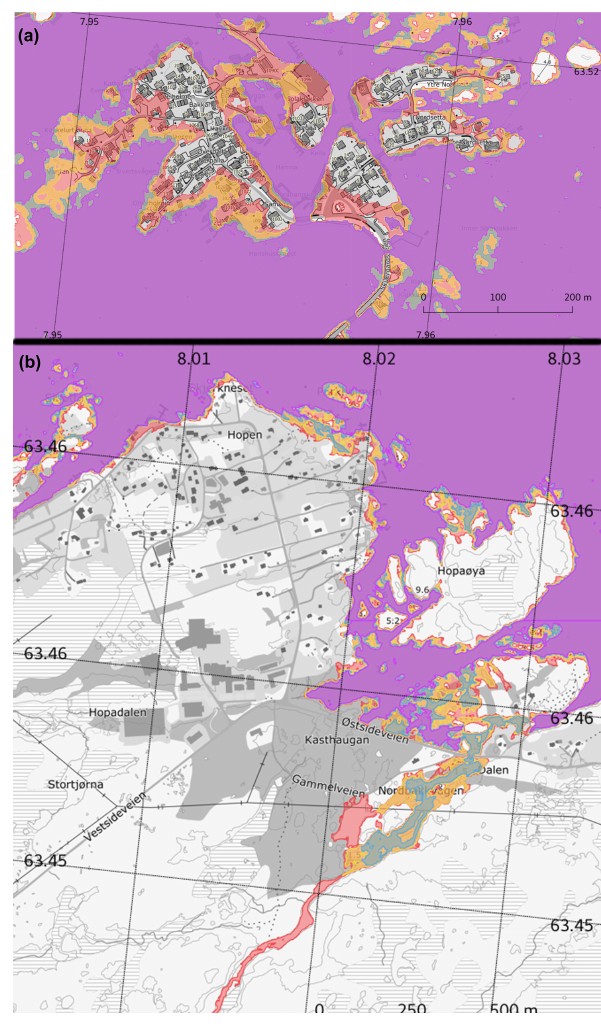
Figure 4. Stack of inundation maps covering the northern part of the island Smøla (a) and the fishing village of Veiholmen (b) , located on the strandflat in the middle of Norway. Violet: present MHW. Green: MHW for 2090 (0.74m above present MHW). Orange: present 200-year storm surge (1.29m above present MHW). Red: 200-year storm surge for 2090 (2.03m above present MHW). Map data shown are provided by Geonorge and Norway Digital consor- Data (NLOD) 2.0 and Creative Commons BY 4.0 (CC BY